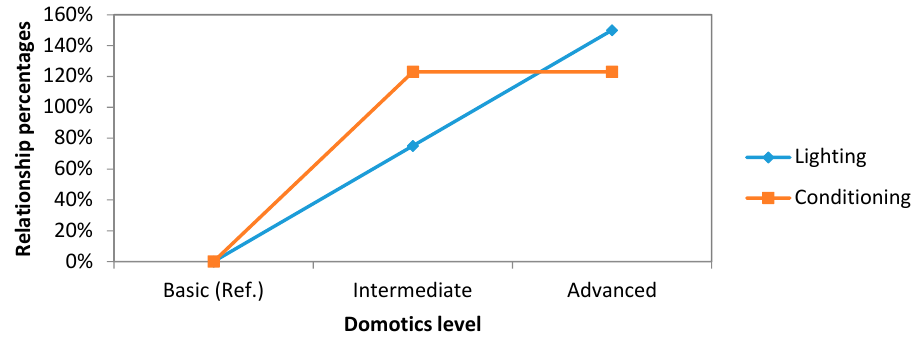
Figure 6. Comparative study graph concerning to energy savings (lighting and conditioning).